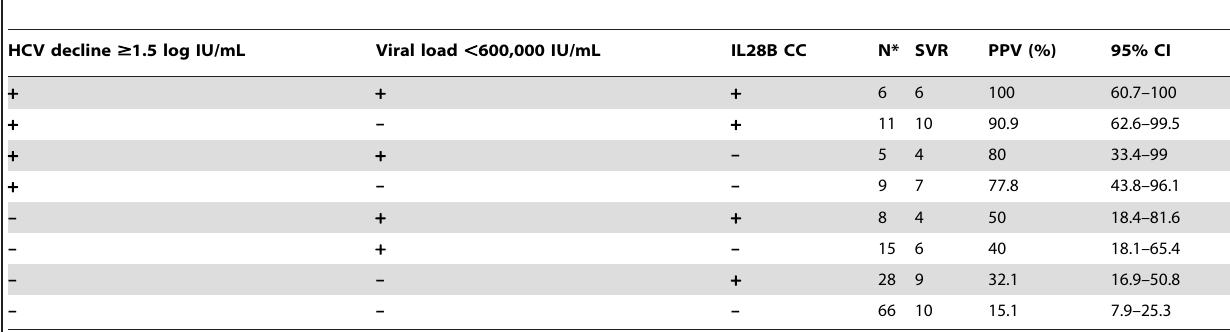
Table 3. Positive predictive value of HCV RNA viral decline at week 2 after starting therapy, HCV baseline viral load and IL28B genotype for Sustained Virological